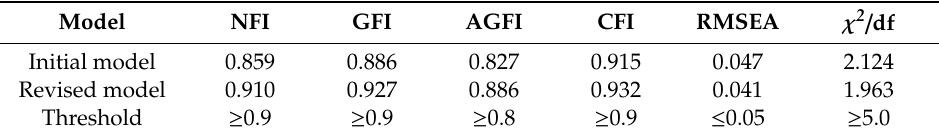
Table 3. Fitness test of the measurement model.